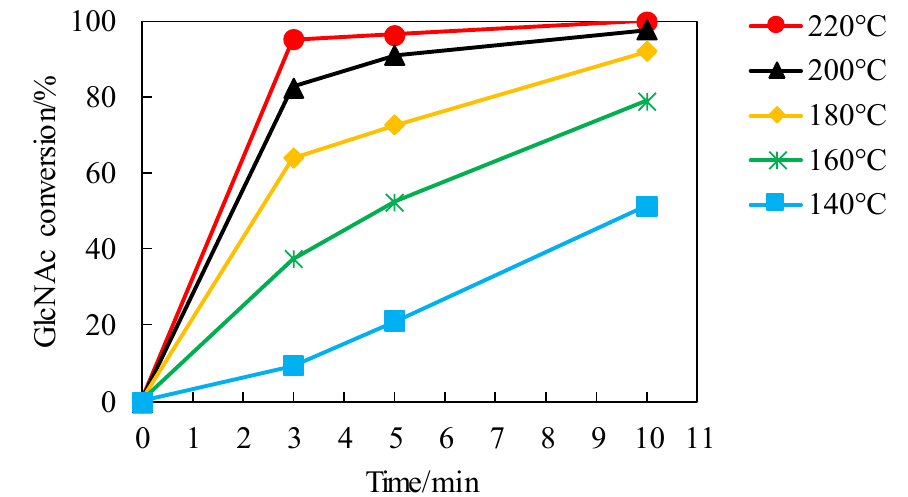
Figure 1. The plots of the GlcNAc conversion as a function of the reaction time.